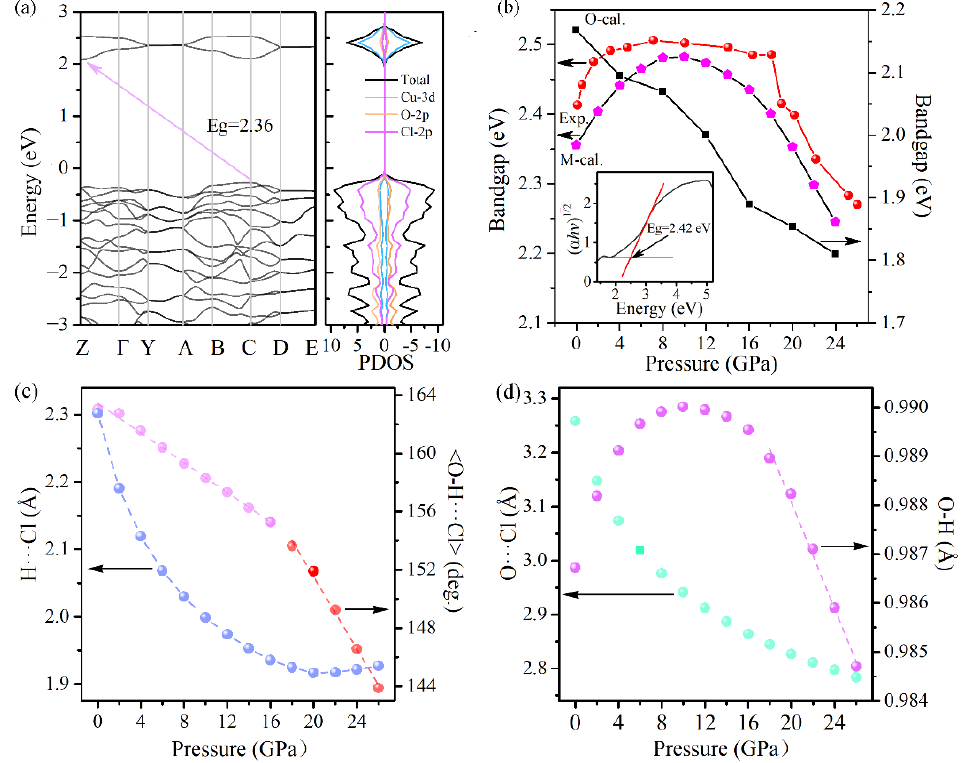
Figure 8. ( a ) The calculated electronic band structure and the partial density of states of Cu(OH)Cl at 0 GPa. ( b ) The experimental and calculated pressure dependences of the bandgaps of Cu(OH)Cl. The inset shows the linear range presented by the absorption edge of Cu(OH)Cl, corresponding to an indirect ( α 1/2 ) bandgap at ambient pressure. ( c , d ) The evolutions of the bond lengths with pressure for H − O, H···Cl, O − Cl, and the bond angle <O − H···Cl> in the monoclinic phase.